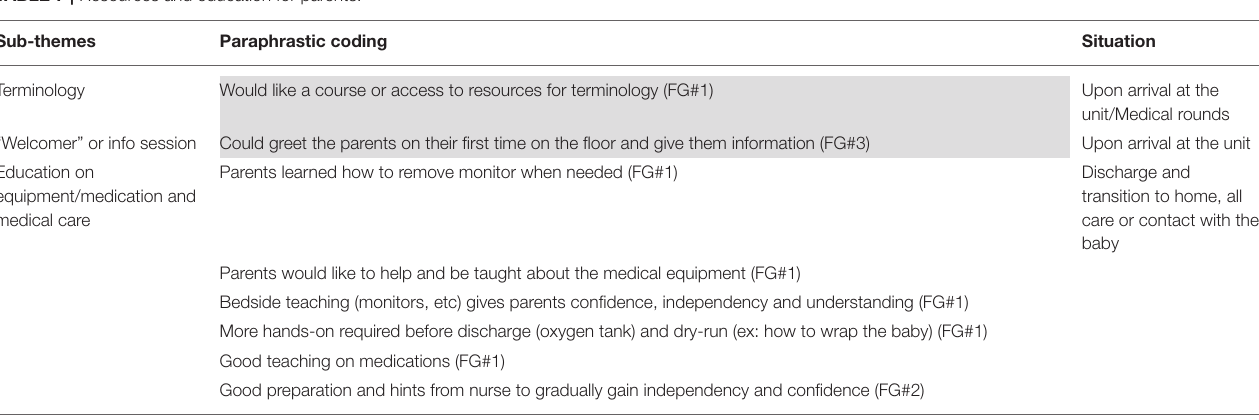
TABLE 7 | Resources and education for